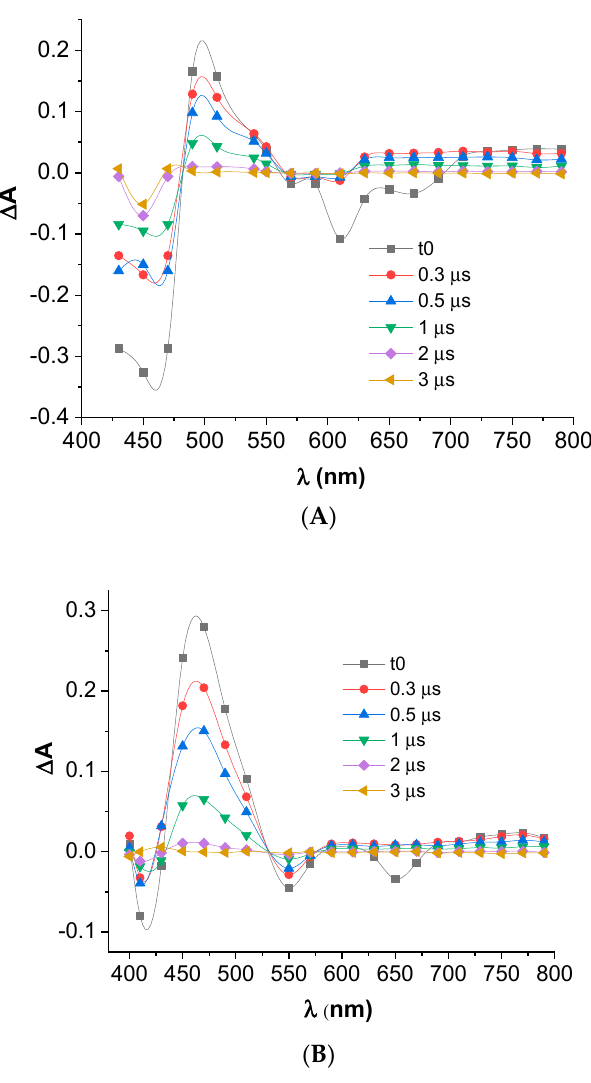
Figure 10. Transient absorption spectra of 1 ( A ) and 2 ( B ) at different delays from the 532 nm ns-laser excitation recorded in 1:1 EtOH/toluene; 350 Ω oscilloscope impedance. Recombination kinetics of the CS state (SnO 2 (e − )-dye(h + )) were monitored at 690 and 700 nm corresponding to the diagnostic CS absorption manifold of porphyrins 1 and 2 , respectively. In general, the dynamics are multiexponential due to surface heterogeneity, with at least one fast